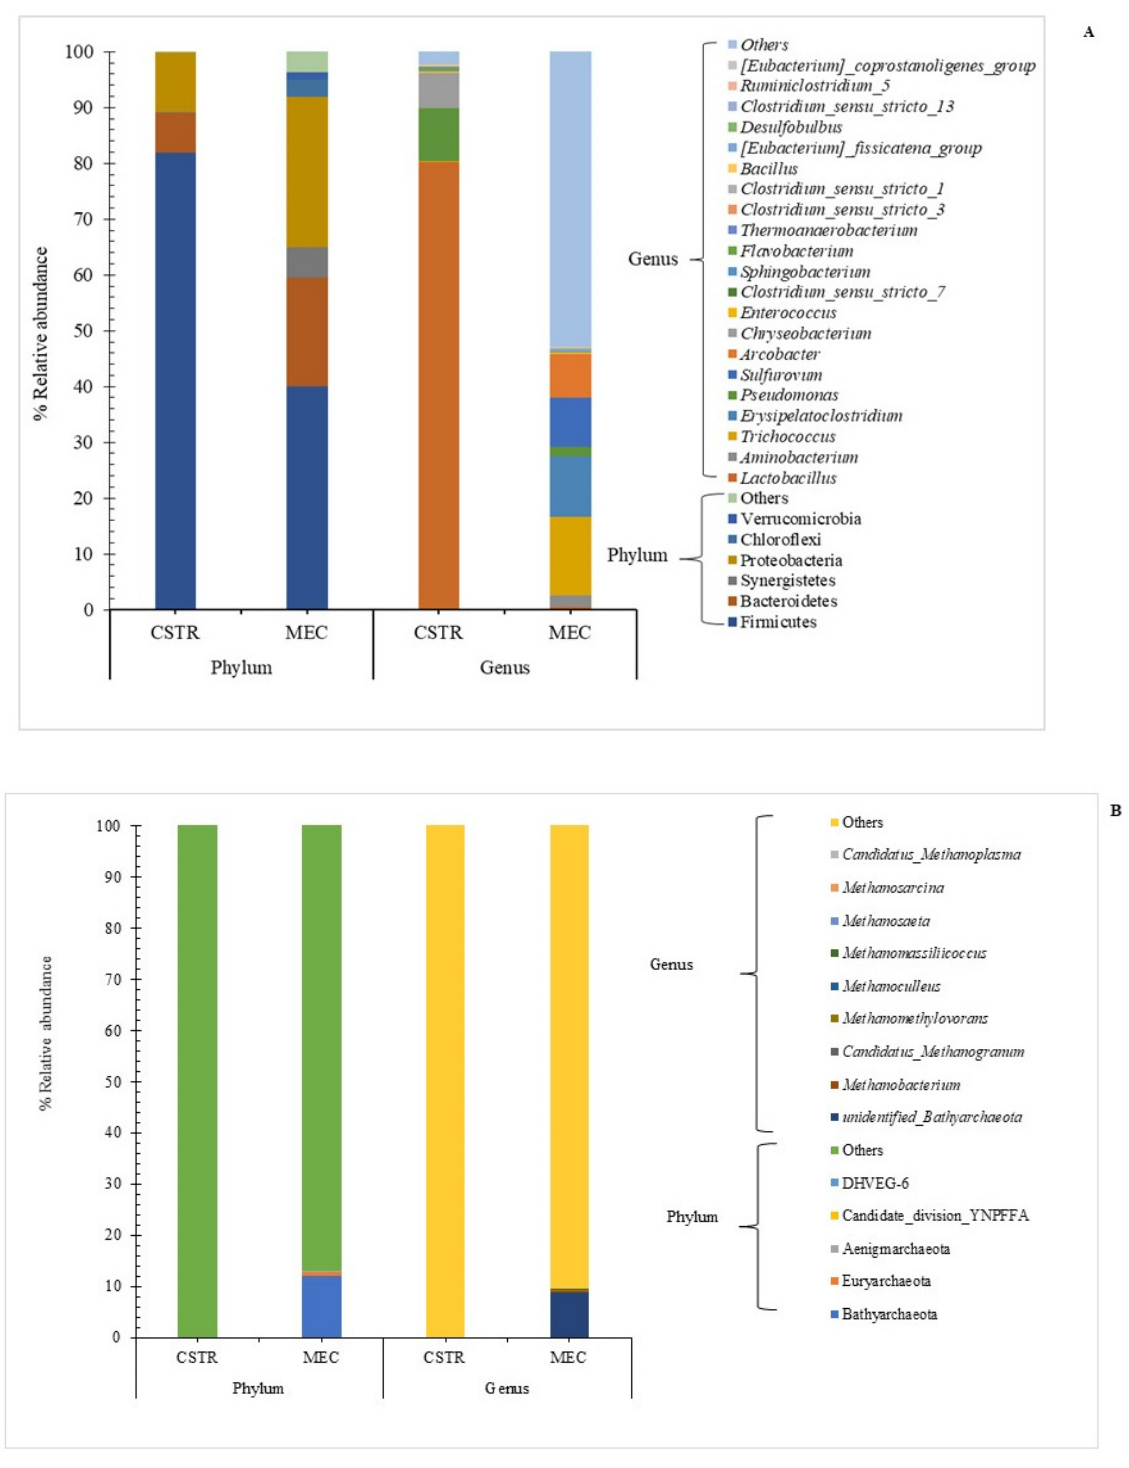
Figure 5. Relative abundance of the dominant microbial taxonomic groups separated using the total 16S rRNA gene sequences. ( A ) Bacterial species at the phylum and genus levels and their respective distribution bar charts of relative abundance. “Others” represents the total relative abundance of the remaining genera. ( B ) Archaea species at phylum and genus levels and their respective distribution bar charts of relative abundance. “Others” represents the total relative abundance of the remaining genera. CSTR and MEC are the continuously stirred tank reactor and microbial electrolysis cell reactor.